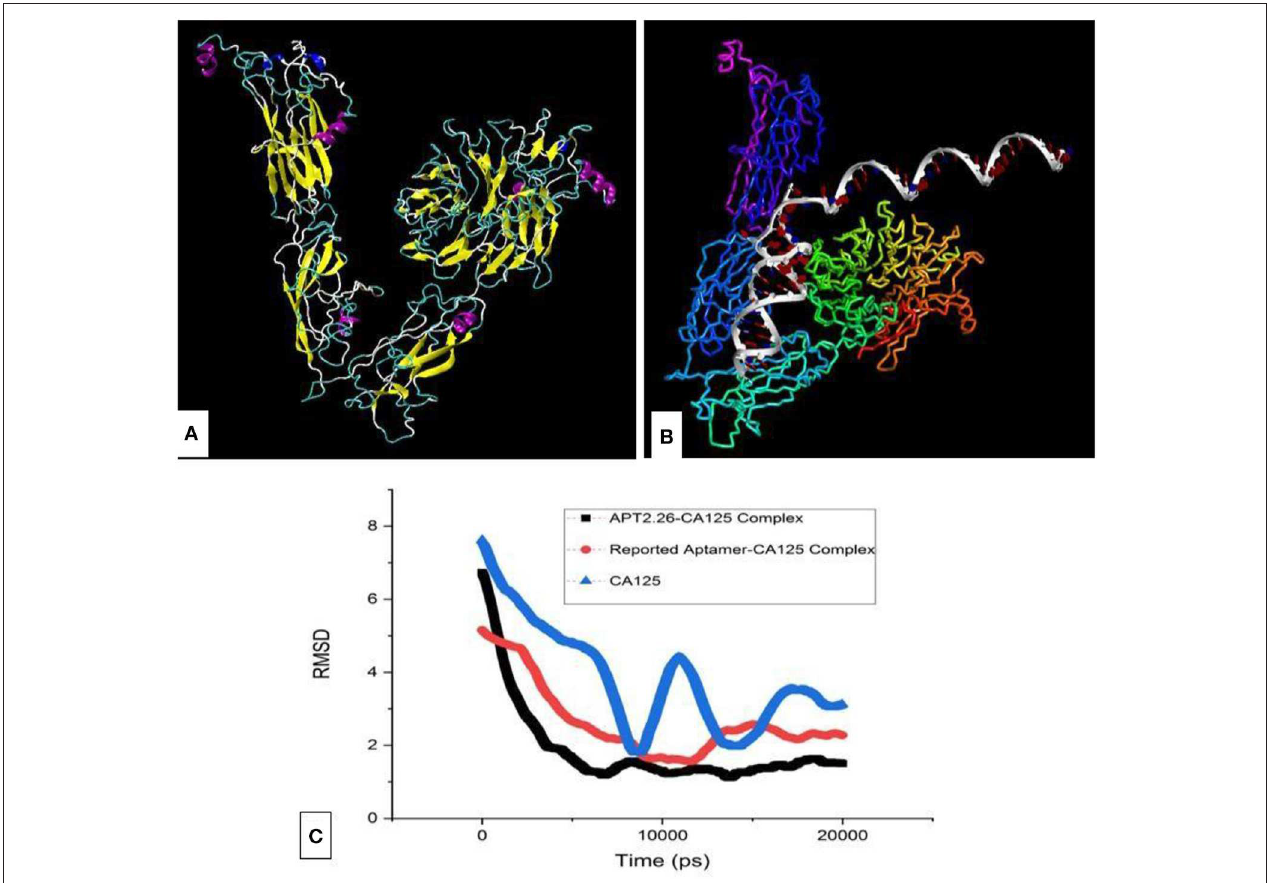
FIGURE 3 | (A) The tertiary structure of the antigenic domain of CA125 and its (B) complex with aptamer 2.26. (C) Molecular dynamics simulation of CA125 alone as well as in complex with Apt 2.26 and reported aptamer, respectively.